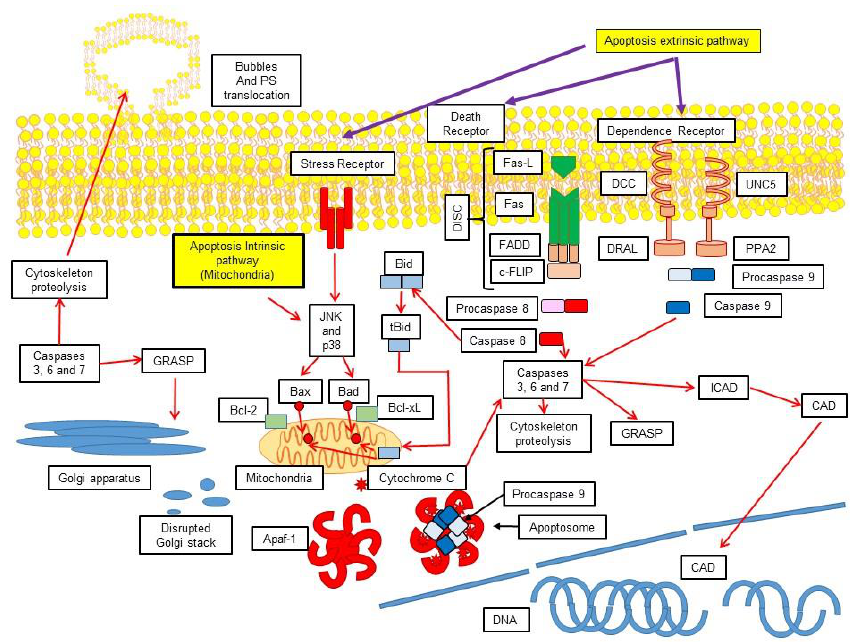
Figure 1. Apoptosis extrinsic and intrinsic (mitochondrial) pathways. Schematic representation of the extrinsic activation pathway and the mitochondrial intrinsic pathway. The extrinsic pathway can be activated through transmembrane death receptors (i.e., Fas, TRAIL, etc.) that detect extracellular stress signals or through dependence receptors (i.e. Uncoordinated 5 A-D (Unc5A-D), Deleted in Colorectal Cancer (DCC) which are activated when the correspondent ligand concentration is below a critical threshold; the intrinsic pathway is activated through intracellular stimuli, such as genotoxic damage, elevated calcium concentration or oxidative stress. The B-cell lymphoma 2 (Bcl-2) proteins participate in this